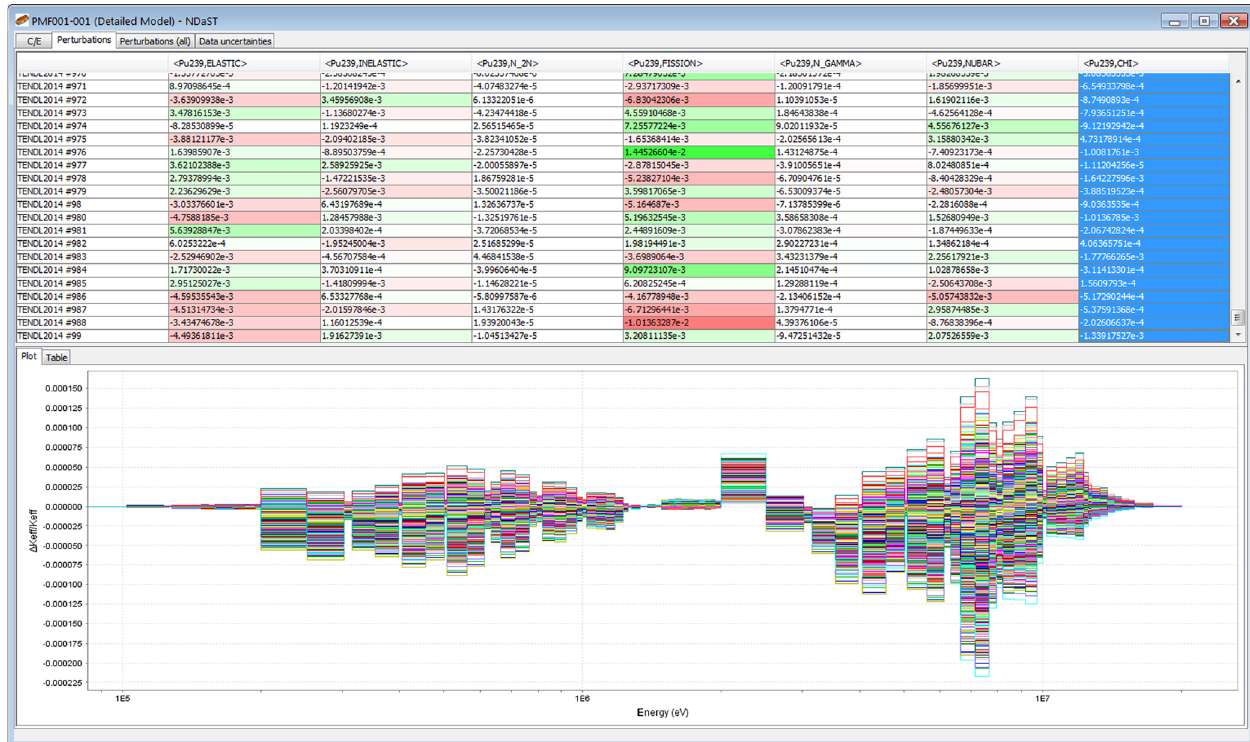
Fig. 1. NDaST output panel of D k eff for PFNS for each random fi le as a function of